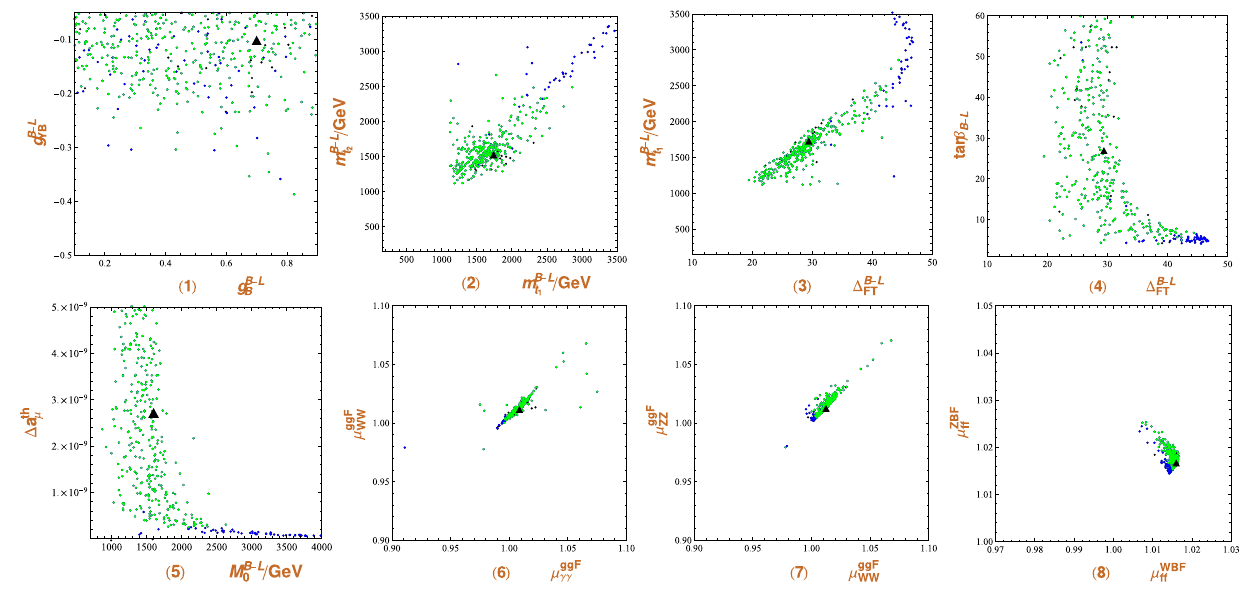
Fig. 3 The fitting results for B-LSSM with the χ 2 analyses